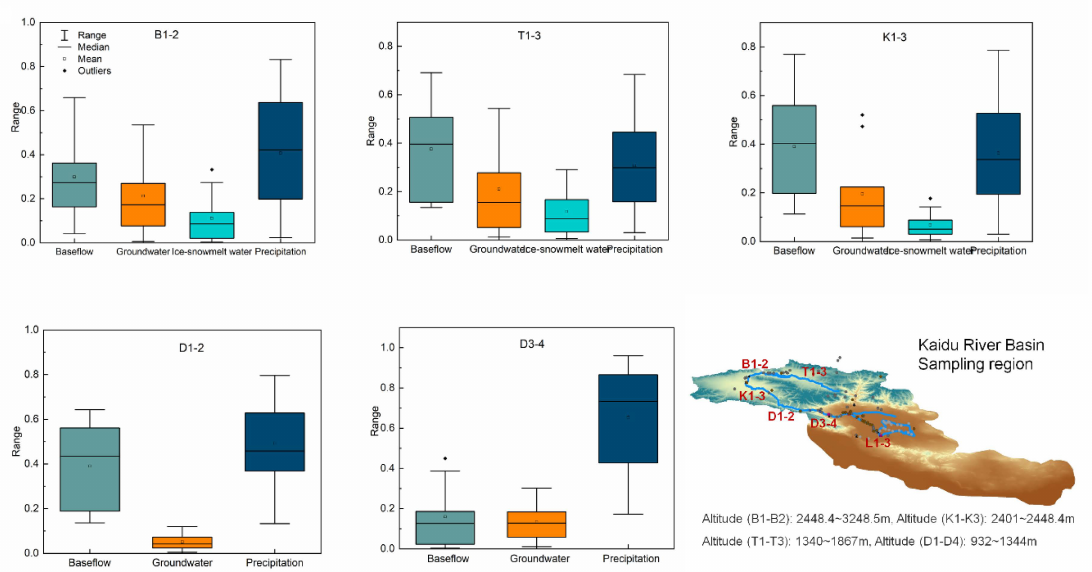
Figure 5. The MixSIAR-derived source water contributions to the mainstream at the outlet (B1–B2), tributary (T1–T3), midstream (K1–K3) and downstream (D1–D4). The boxplots represent the distribu- tions of potential source water contributions derived by a Bayesian approach for MixSIAR. The boxes show the medians and 25th/75th percentiles, with the whiskers indicating the 5th/95th percentiles. The crosses point out absolute extreme values. Baseflow (light cyan), groundwater (orange), ice and snow melt (blue) and precipitation (navy